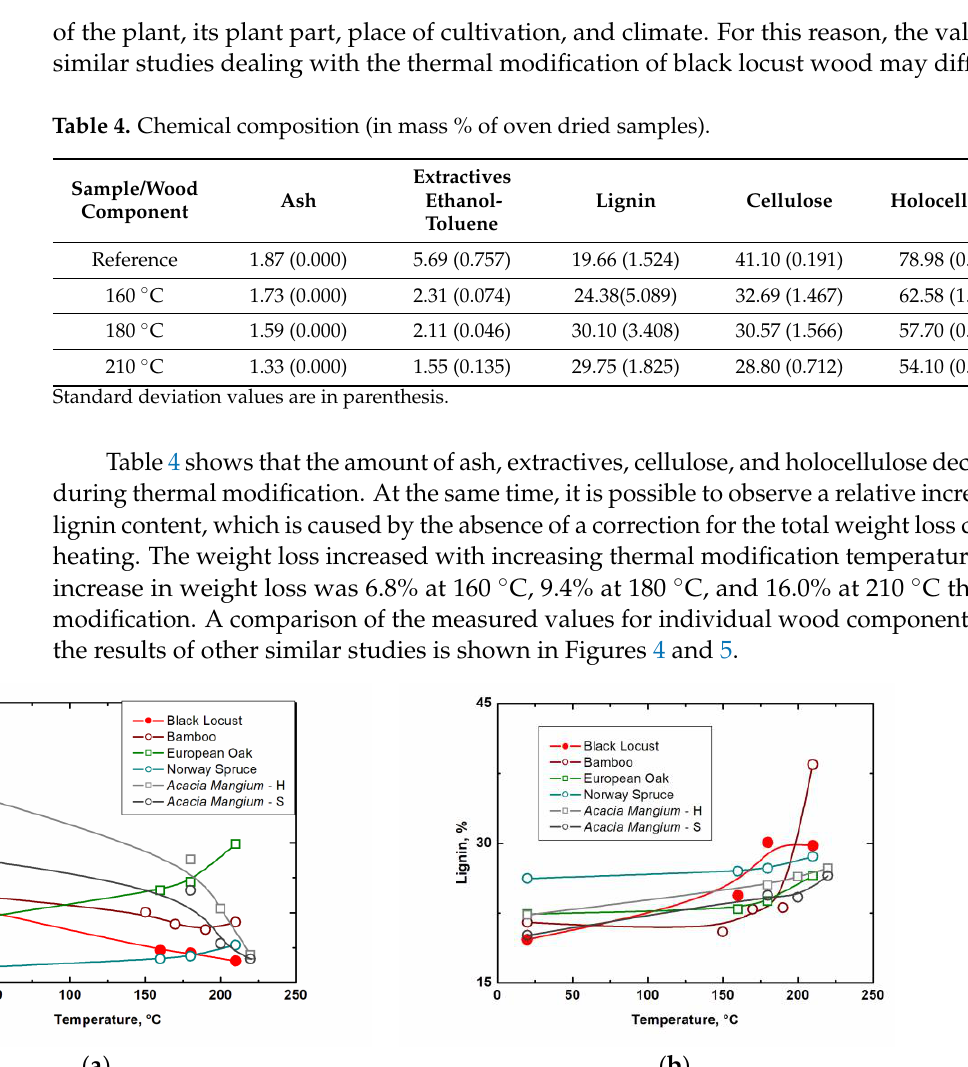
Figure 4. ( a ) Influence of thermal modification on extractives; ( b ) influence of thermal modification on lignin (bamboo [19], European oak, Norway spruce [20], Acacia Mangium — heartwood, sapwood [21]).